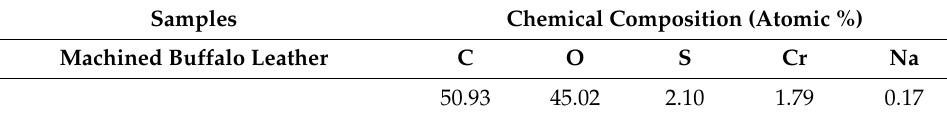
Table 3. Elemental analysis of laser-machined leather.